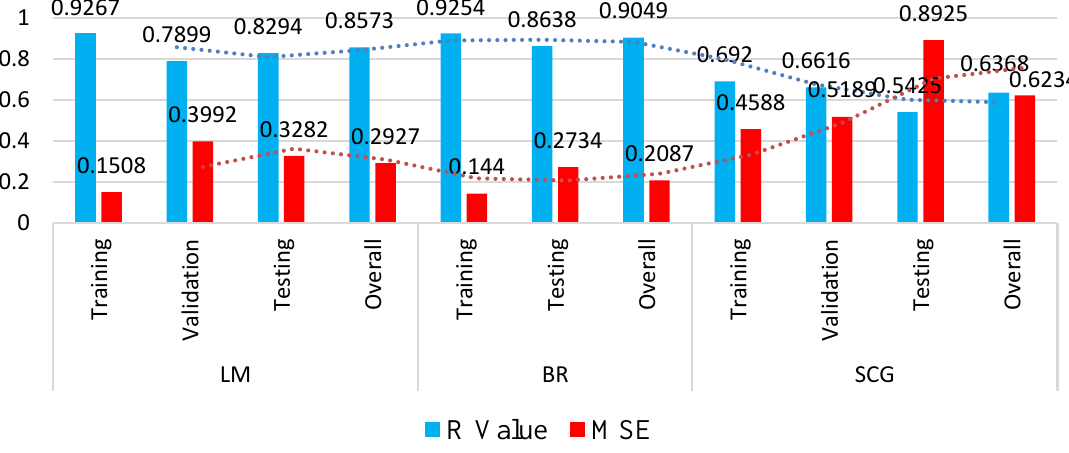
Figure 15. Comparison of experimental and predicted values by ANN of ( a ) LM, ( b ) BR, and ( c ) SCGB algorithms.